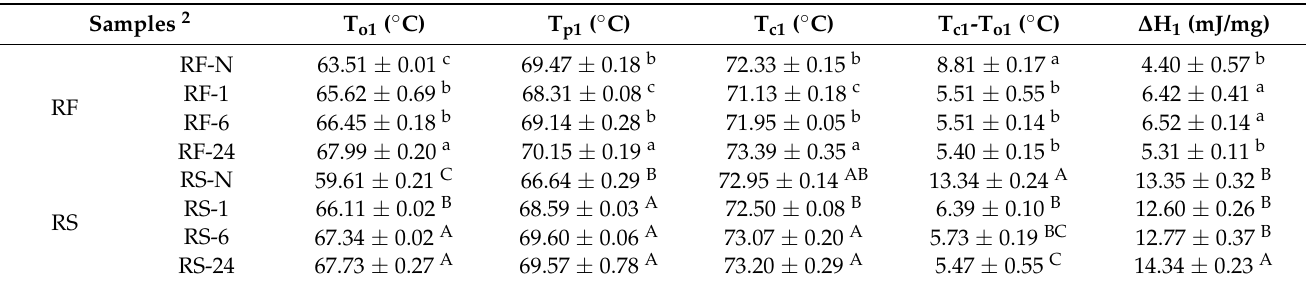
Table 5. The DSC parameters 1 of native and partially hydrolyzed RF (the first endothermic peak) and